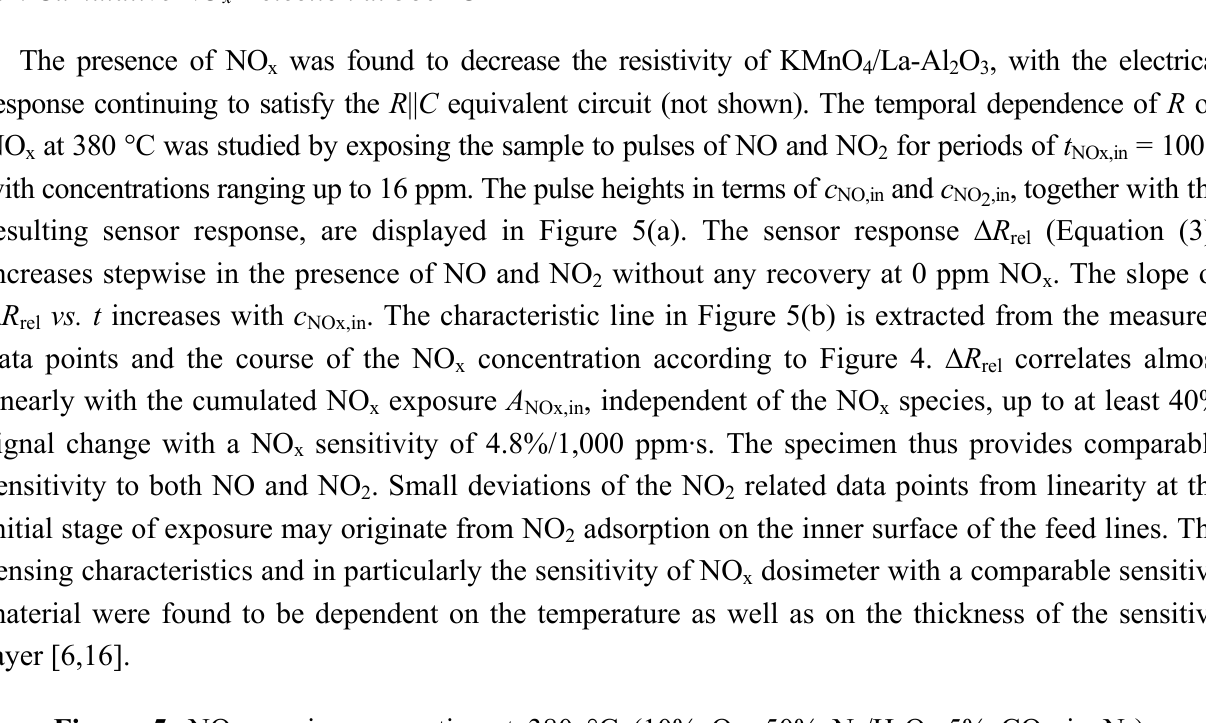
, 50% N /H O, 5% CO 2 2 2 (Equation (3)) during cyclic exposure to NO rel vs. A characteristic rel NOx,in